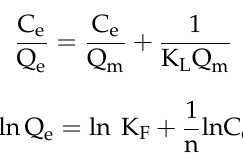
Table 3. Phosphate adsorption isotherm parameters for adsorbents.